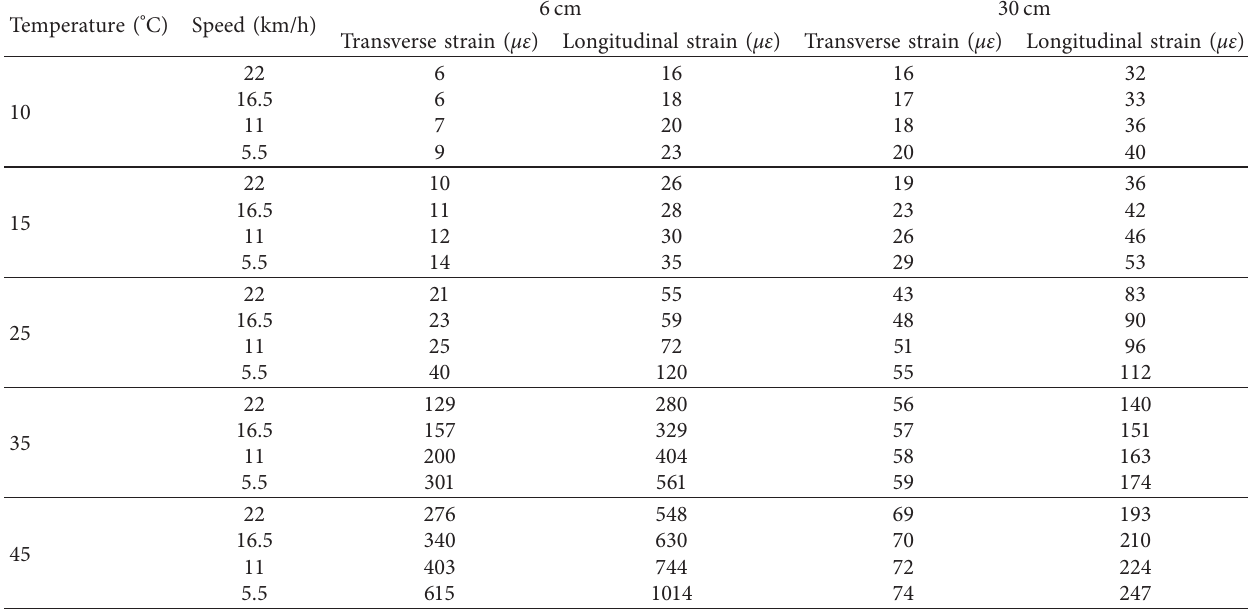
Table 3: Strain values of asphalt layer in the flexible pavement at different